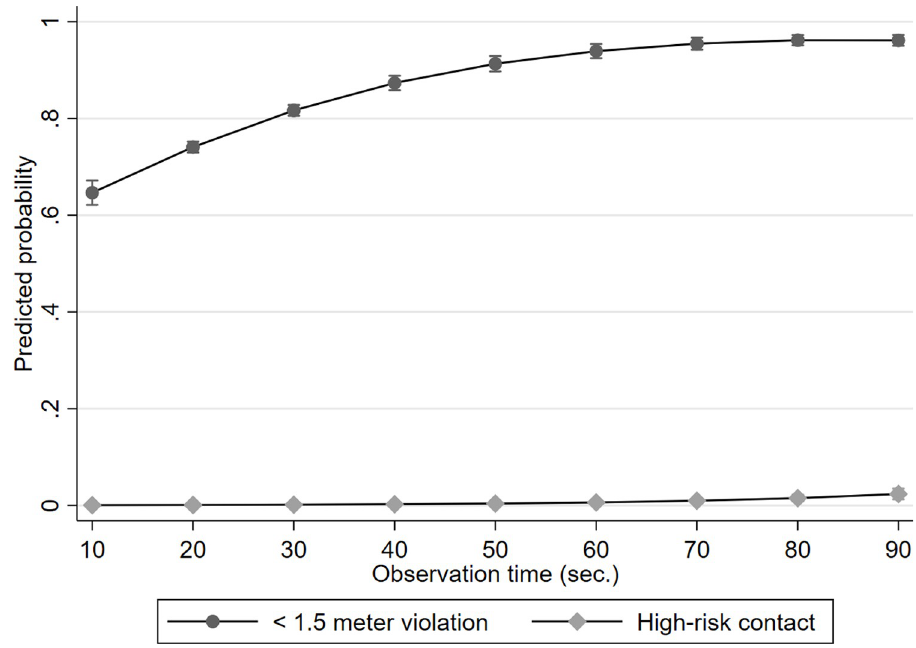
Fig 2. 1.5-meter and high-risk violations regressed on observation time. Note . The ordinal regression model was estimated with three outcome levels, but for brevity, we do not graph the no-violation outcome